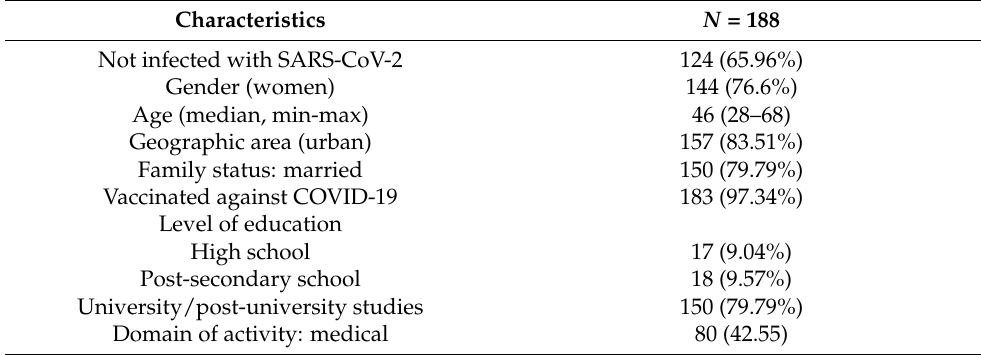
Table 2. Vaccination/infectious COVID-19 status, socio-demographic, and educational characteristics of respondents who had vaccinated their children (12–18